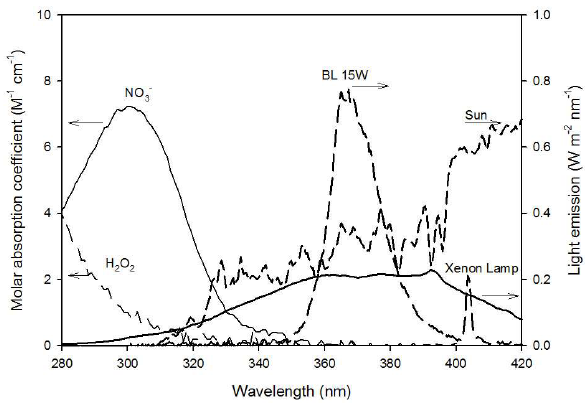
Fig. 1. Emission spectra of the 1000W xenon lamp (P1), of the Philips Actinic BL 15W lamps (P2), of the Sun at the Earth’s sur- face and molar absorption coefficients of nitrate and H 2 O 2 aqueous